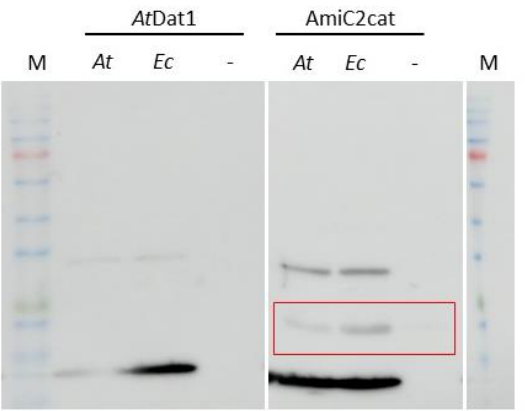
Figure 4. PGN from E. coli and Arabidopsis chloroplasts lead to precipitation of AmiC2cat in PGN binding assays. In the left panel bound AtDAT1, and in the right panel bound AmiC2cat in PGN preparations from A. thaliana ( At ), E. coli ( Ec ) and with no added PGN (–) are shown. Precipitated AminC2cat by PGN is marked by a red box.